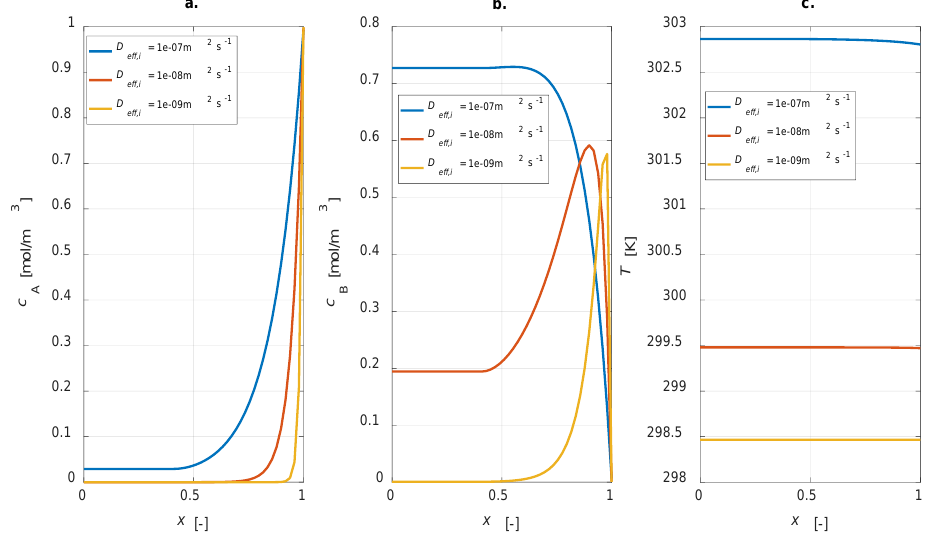
Figure 9. Intraparticle profiles: D eff,i sensitivity study. ( a ) A concentration; ( b ) B concentration; ( c ) temperature.